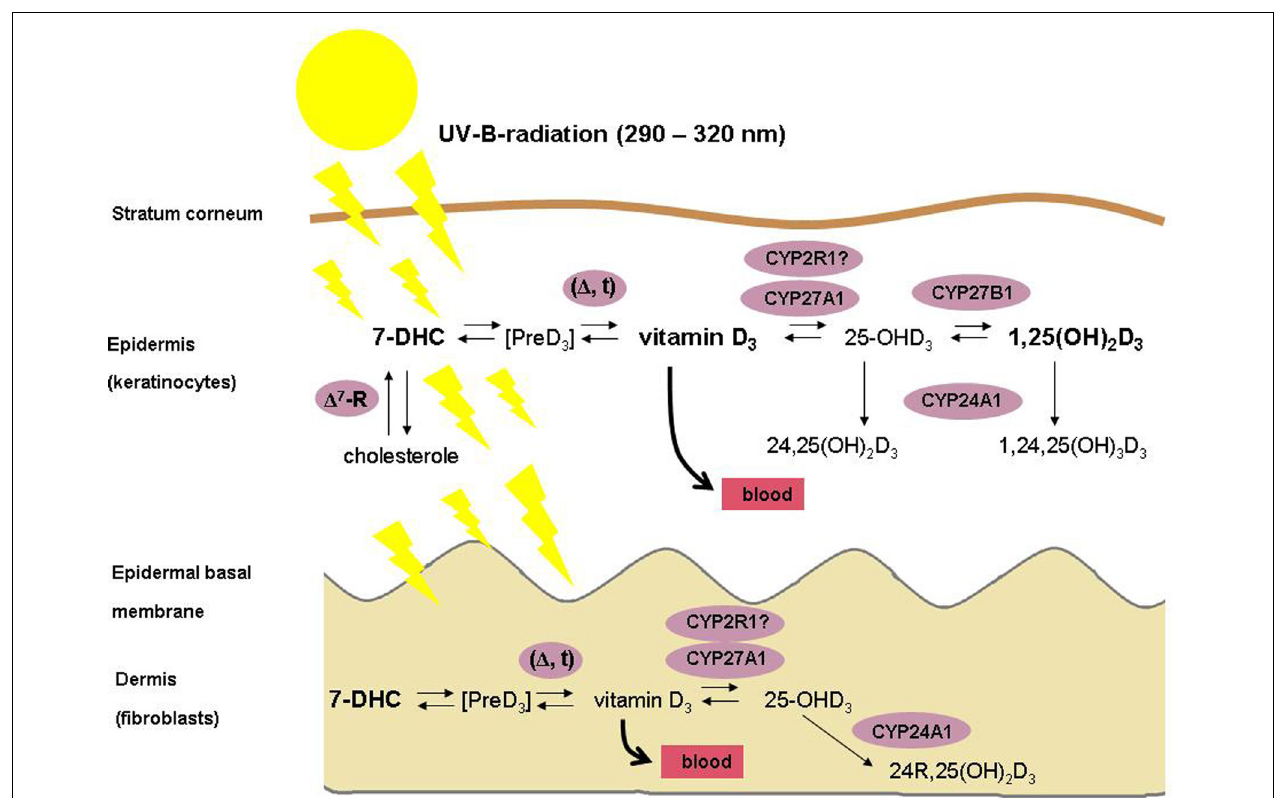
FIGURE 1 | Schematic illustration of the vitamin D metabolism in human skin. Please note that, in contrast to fibroblasts, keratinocytes possess the enzymatic machinery for the complete synthesis of 1,25-dihydroxyvitamin D from 7-dehydrocholesterole (7-DHC).